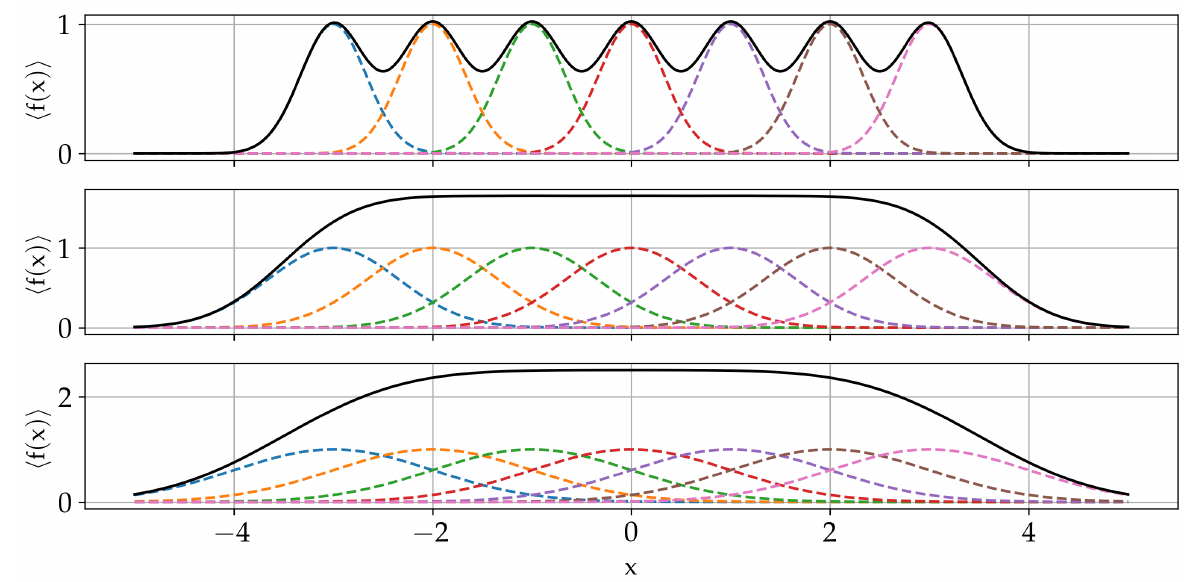
Figure 6. Conceptual example of the effect that the smoothing length has on (cid:104) f ( x ) (cid:105) for multiple point-particles, separated one length unit, and with Gaussian function as kernel. The smoothing lengths employed in the examples are: h = 1, upper plot; h = 2, middle plot; and h = 3, bottom